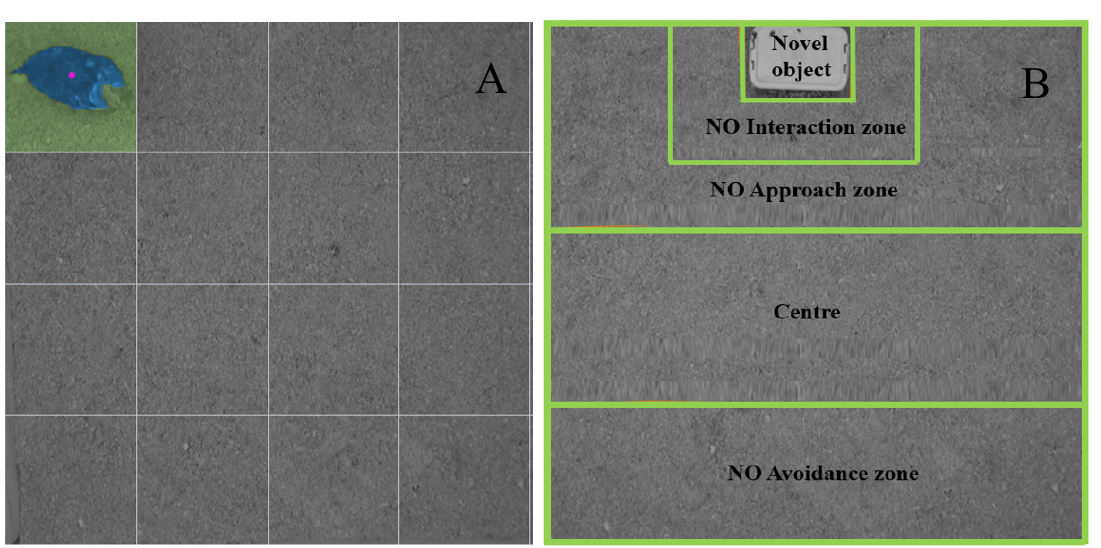
Figure 4. Layout of novel arena (NA) test from the ANYmaze software that was used to determine di ff erent parameters of NA test in the laying hens of a commercial farm. The novel arena was 1.7 m 2 and the lines were virtually overlaid on the video footage using the ANYmaze software to divide the NA into 16 equal squares. ( A ) shows the tracking of the hens by ANYmaze software to determine the number of lines crossed and the total distance moved / hen in the NA. ( B ) Layout of novel object (NO) test from the ANYmaze software that was used to determine di ff erent parameters of NO test. The lines were virtually overlaid on the video footage using the ANYmaze software to divide the NA into four zones of interest; NO avoidance zone, Centre, NO approach zone and NO interaction zone. Automatic tracking at di ff erent zones was done using the software after placing the NO from the trap door. The bright green line across the figure is the virtual scale from the software overlaid on the video used for measurement and dividing the arena into zones. Time spent at these zones and total distance moved were some of the measured parameters.